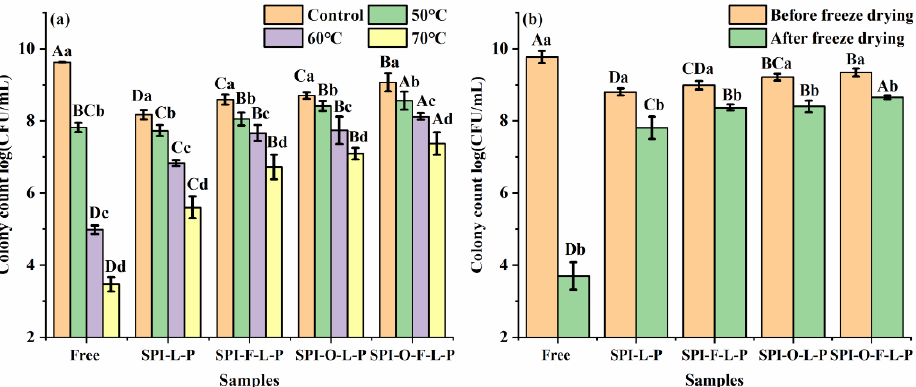
Figure 7. Resistance of different samples to heat treatment ( a ) and freeze drying ( b ). Different uppercase letters indicate significant differences between samples under the same treatment conditions and different lowercase letters represent significant differences between different treatment conditions for the same samples ( p < 0.05).